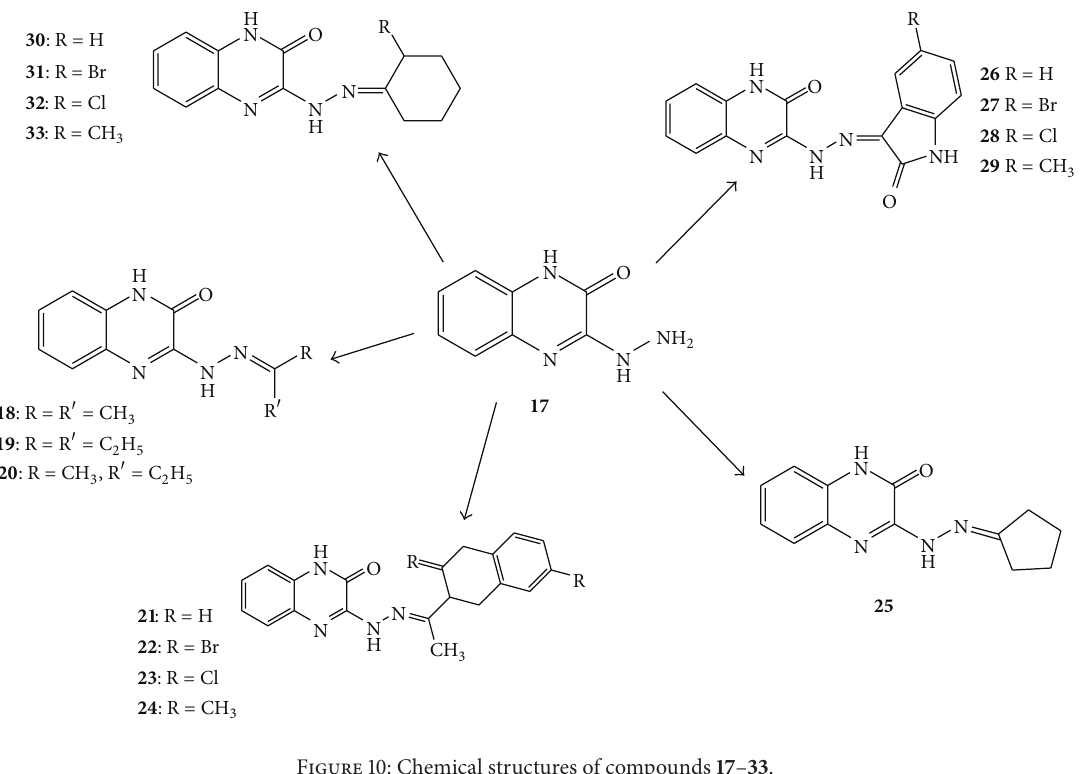
Figure 10: Chemical structures of compounds 17 – 33 .